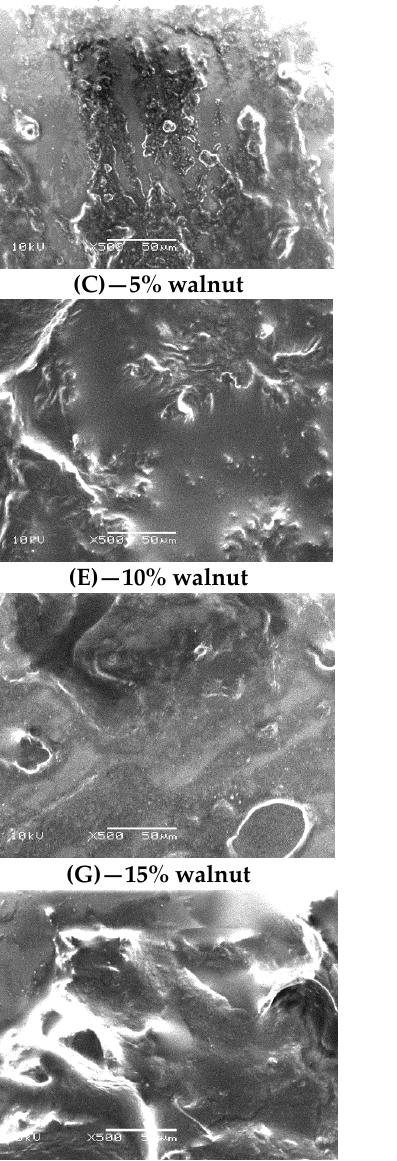
Figure 1. SEM images of processed cheese containing 0% ( A , B ); 5% ( C , D ); 10% ( E , F ) and 15% ( G , H ) walnut paste. At different magnitudes 500× ( A , C , E , G ) and 1000× ( B , D , F , H ); at 10 kV; Bar = 50 μ m .